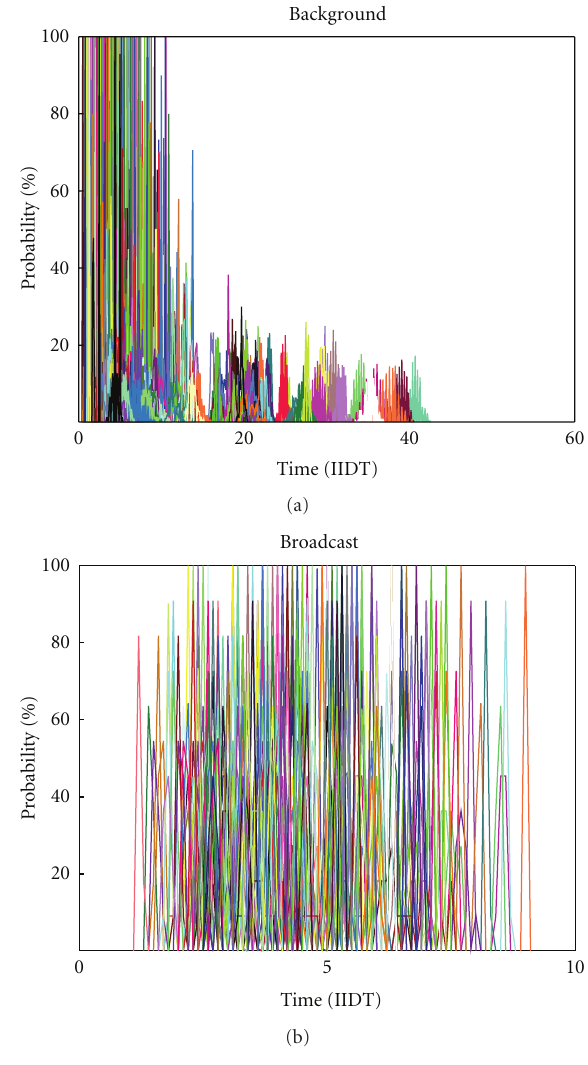
Figure 7: PDF of End-to-End Delay for Germany50